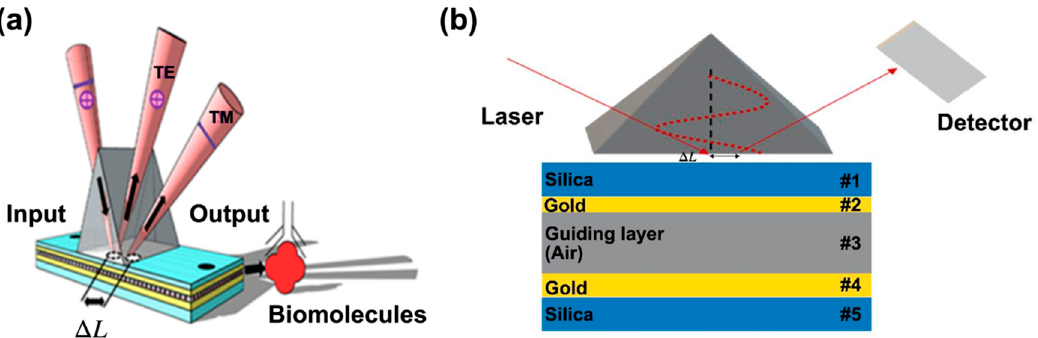
Figure 1. ( a ) Schematic of the symmetrical metal-cladding waveguide biosensor; ( b ) principle model of coupling in SMCW.